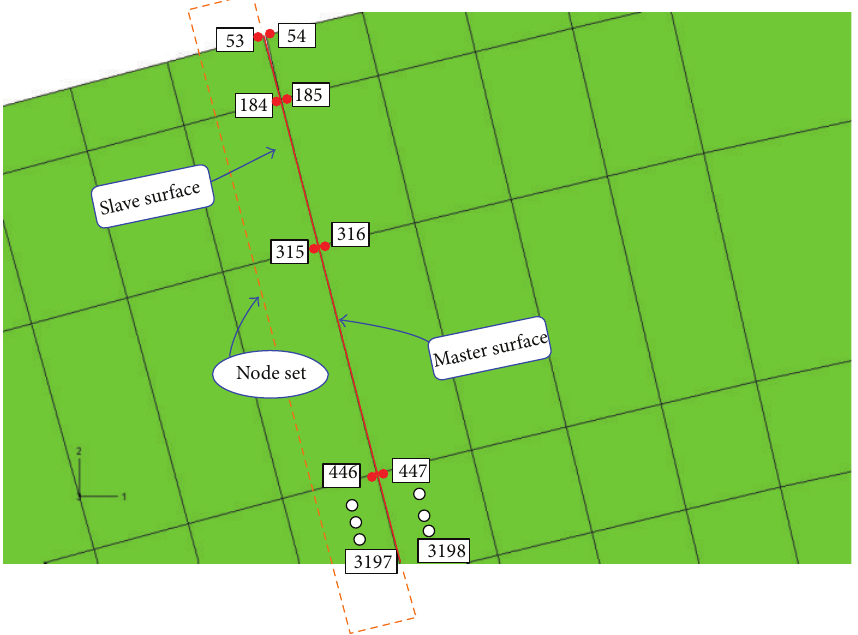
Figure 7: The definition for node set for contact definition.